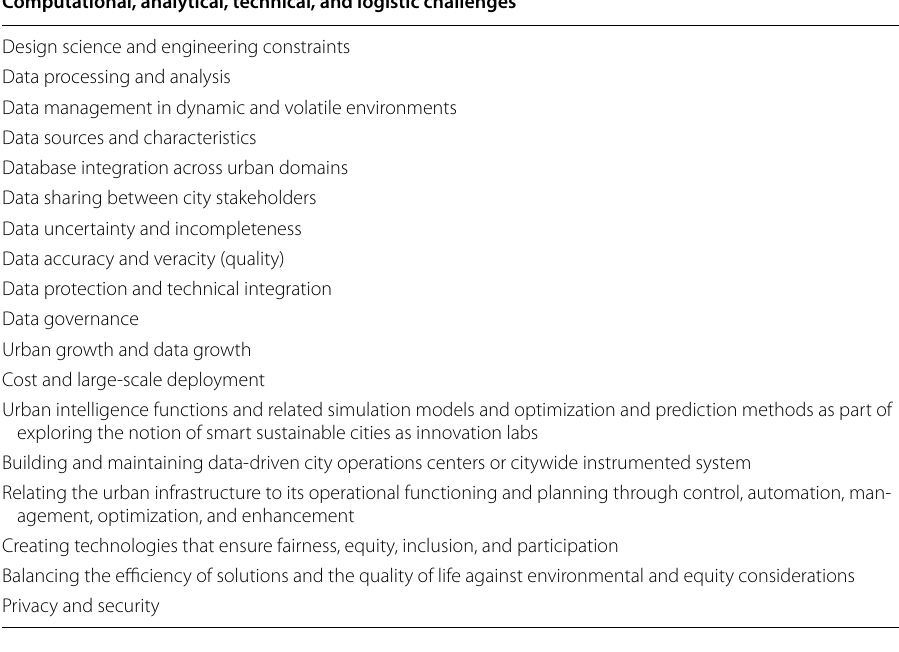
Table 3 Computational, analytical, technical, and logistic challenges Source: Bibri [12] Computational, analytical, technical, and logistic challenges Design science and engineering